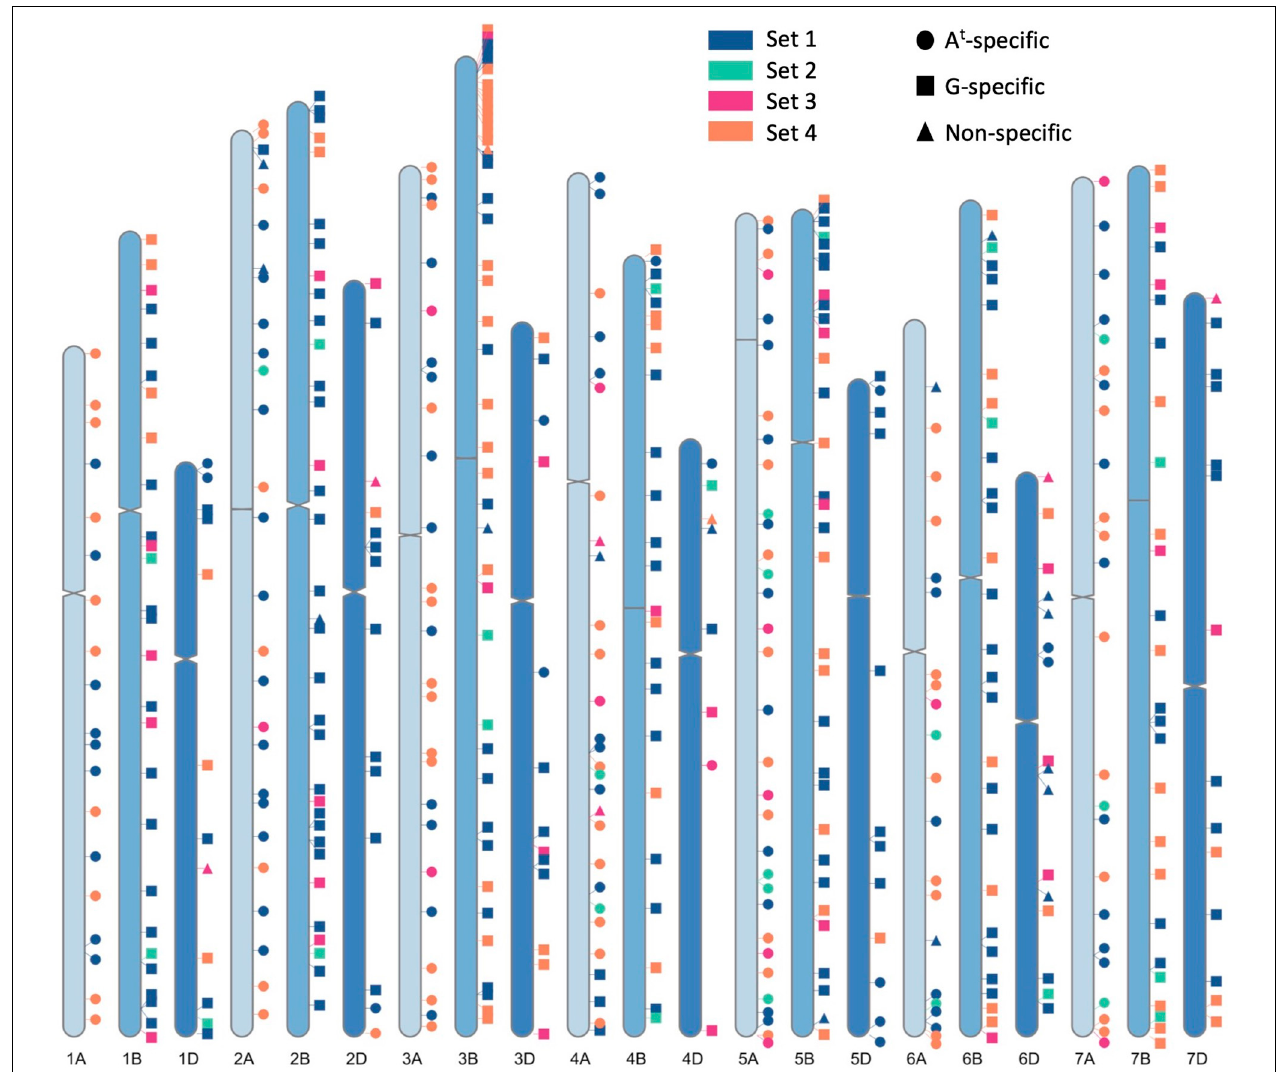
FIGURE 2 | A graphical representation of physical positions of the four sets of chromosome-specific KASP markers, across all wheat chromosomes, used in this study to characterise wheat- Triticum timopheevii introgression lines. Sets 1, 2 and 3 were developed in previous works (Grewal et al., 2020a, 2021, 2022) and Set 4 was developed in this study to fill in the gaps between markers from the previous sets. Circles depict KASP markers that specifically detect A t subgenome segments, squares depict markers that detect G subgenome segments and triangles represent markers that detect both subgenomes.